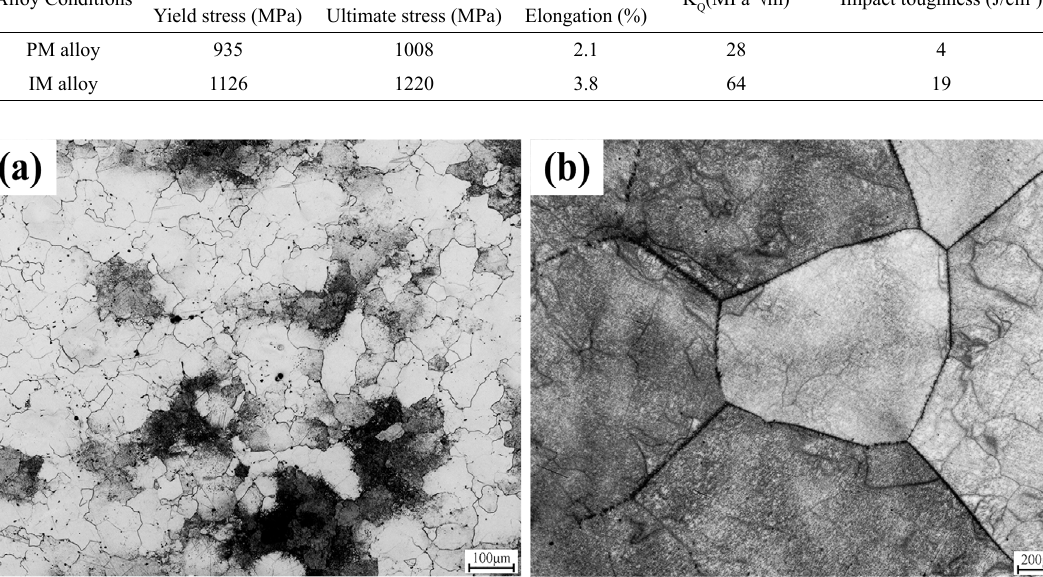
Table 2. Mechanical properties of as-consolidated PM and as-cast IM Ti-5553 alloy. Alloy